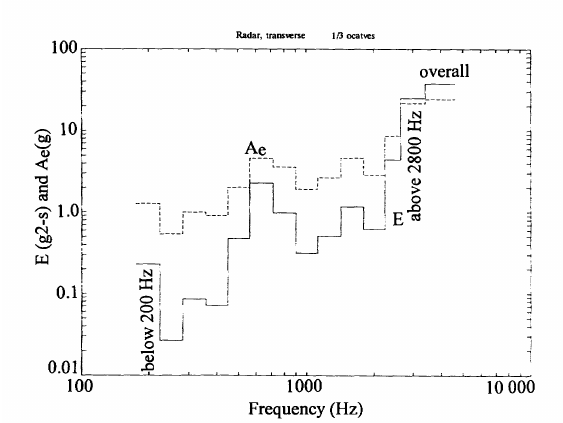
FIGURE 11 Energy and root energy amplitude of the time history of Fig. 5.